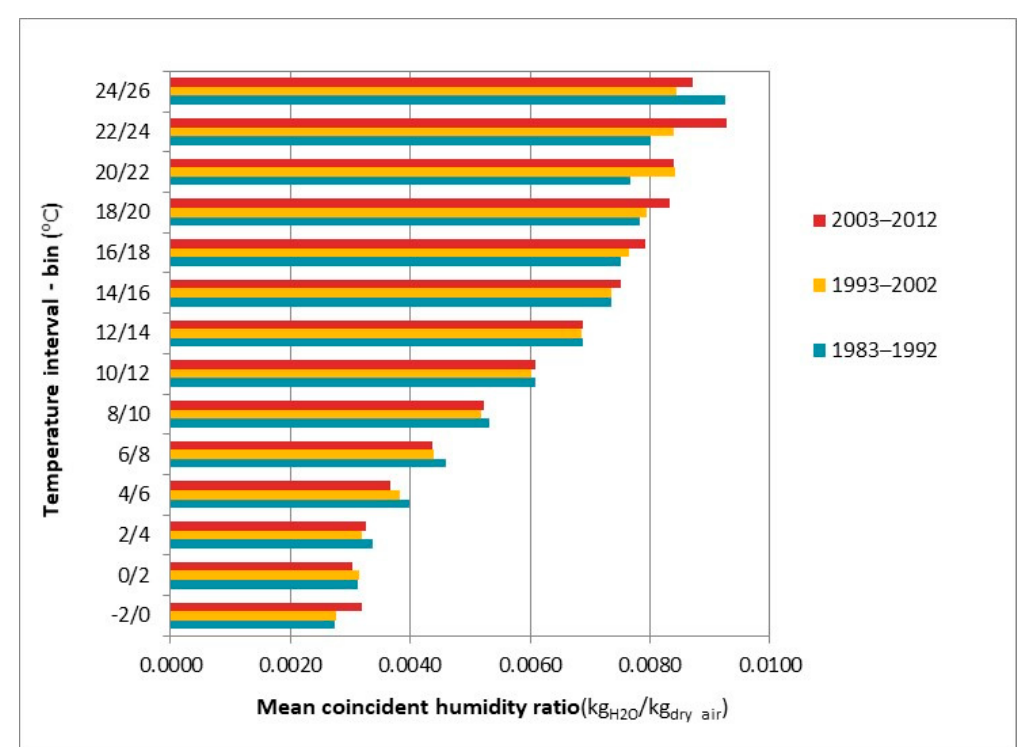
Figure 6. Mean coincident humidity ratio, in 2 °C temperature intervals, Athens (NOA) (heating season—November to April).